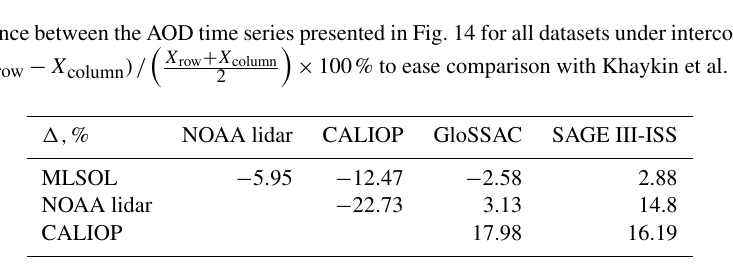
Table 2. Mean relative difference between the AOD time series presented in Fig. 14 for all datasets under intercomparison. The mean relative difference is calculated as (X row − X column )/